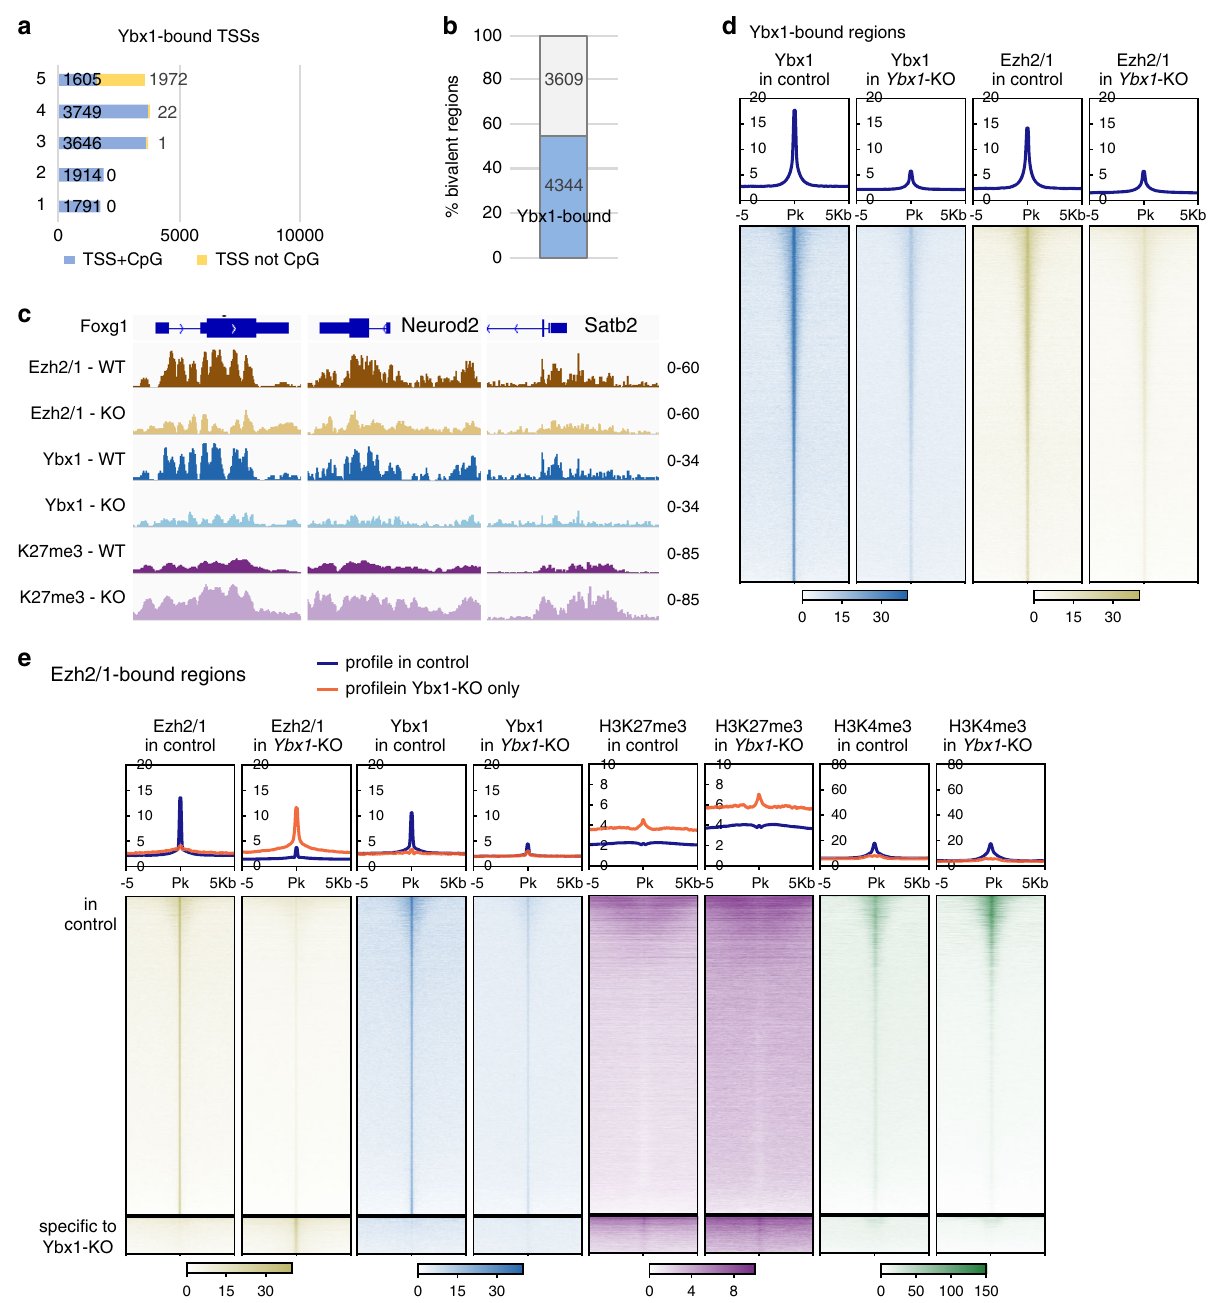
Fig. 5 Ybx1 is required for appropriate levels of PRC2 binding to chromatin. a Proportions of Ybx1-bound TSSs (categories 1 – 5 based on H3K27me3 and H3K4me3 distribution in Fig. 4) that overlapped CpG islands. b Percent of bivalent (co-occupied by H3K27me3 and H3K4me3) regions that overlap Ybx1- bound regions. c Ezh2/1 and Ybx1 CUT&RUN-seq tracks and H3K27me3 ChIP-seq at Foxg1 , Neurod2 , and Satb2 gene loci in Ybx1 -KO and sibling control NPCs. d Heat maps of Ybx1 and Ezh2/1 distribution within 5 kb of Ybx1 CUT&RUN-seq peaks. e Heat maps of Ezh2/1, Ybx1, H3K27me3, and H3K4me3 within 5 kb of Ezh2/1 CUT&RUN-seq